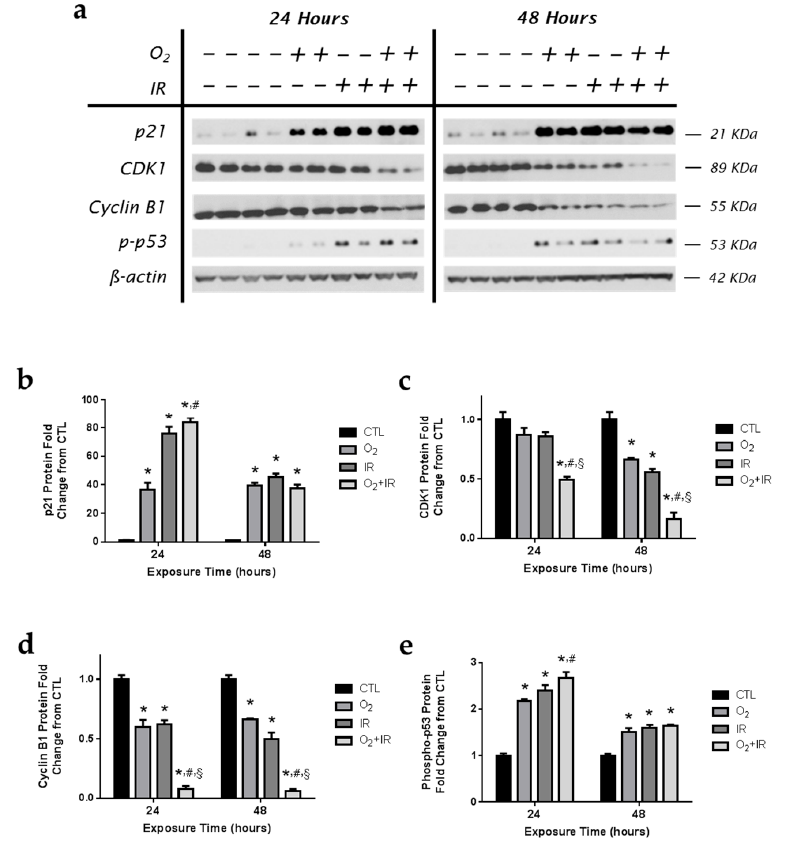
Figure 5. Hyperoxia and radiation exposure induce changes in cell cycle proteins. Non-tumorigenic murine alveolar type II epithelial cells (C10) were evaluated after 1 and 2 cycles of hyperoxia and radiation exposure and evaluated by ( a ) western blotting for p21, CDK1, and Cyclin B1, and phospho-p53. Densitometric analysis of band intensity for ( b ) p21; ( c ) CDK1; ( d ) Cyclin B1; and ( e ) phospho-p53 was normalized to β -actin and values are expressed as fold change from CTL. Data are presented as mean ± SEM. * p < 0.05 for each exposure condition as it compares with the unexposed control (CTL) in the same respective time-group; # p < 0.05 for significant differences between O 2 -alone compared to O 2 + IR; § p < 0.05 for significant differences between IR-alone compared to O 2 + IR.